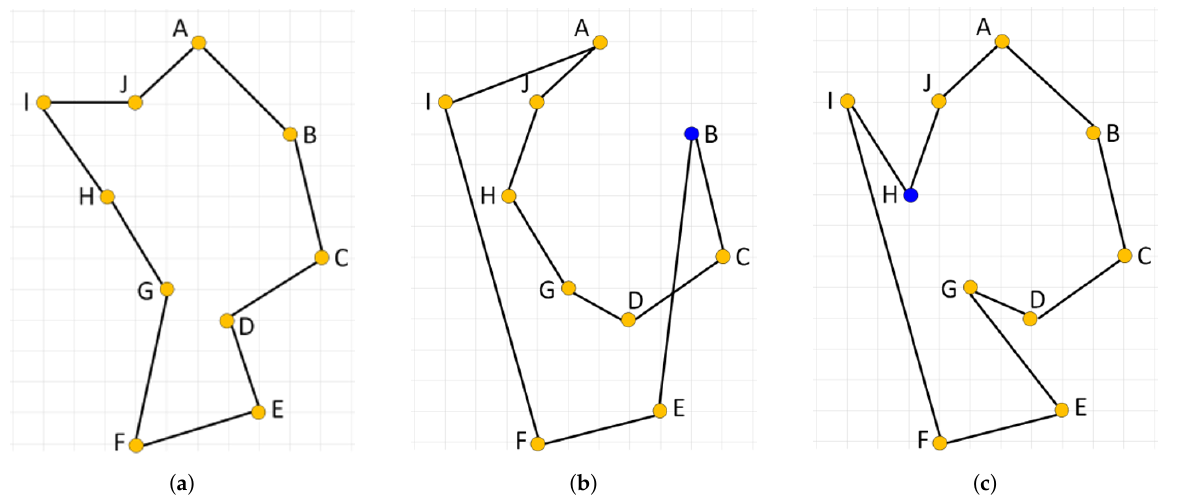
Figure 5. Illustration of an ineffectiveness of the standard nearest neighbor constructive procedure on a simple instance of the TSP. ( a ) shows an optimal solution; ( b ) shows a solution constructed by the nearest neighbor when started from node B; ( c ) shows a solution constructed when the procedure starts from node H.